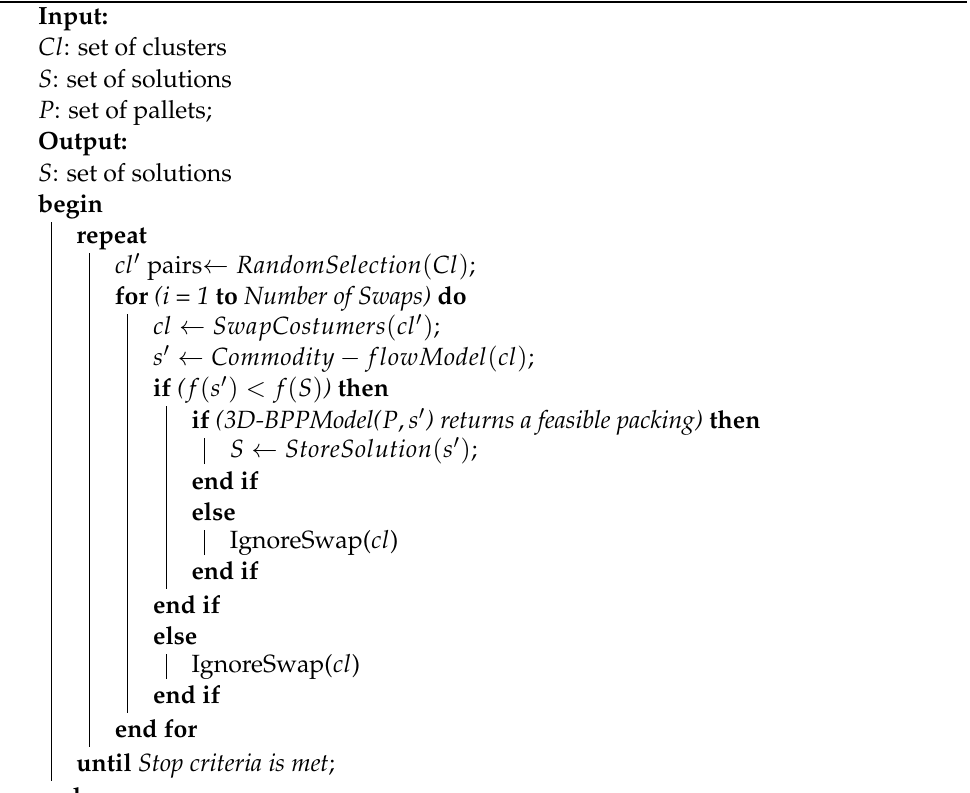
Algorithm 3: Local search